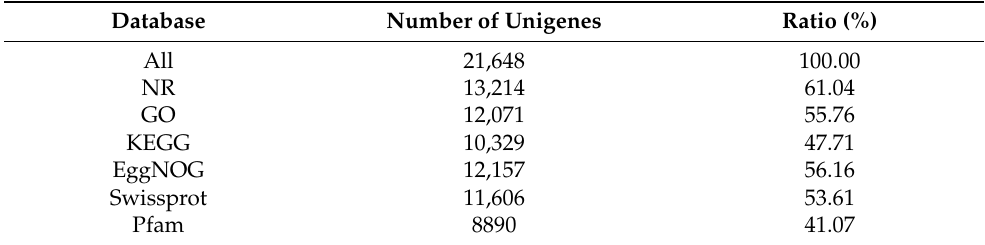
Figure 1. The length distribution of transcripts and unigenes.